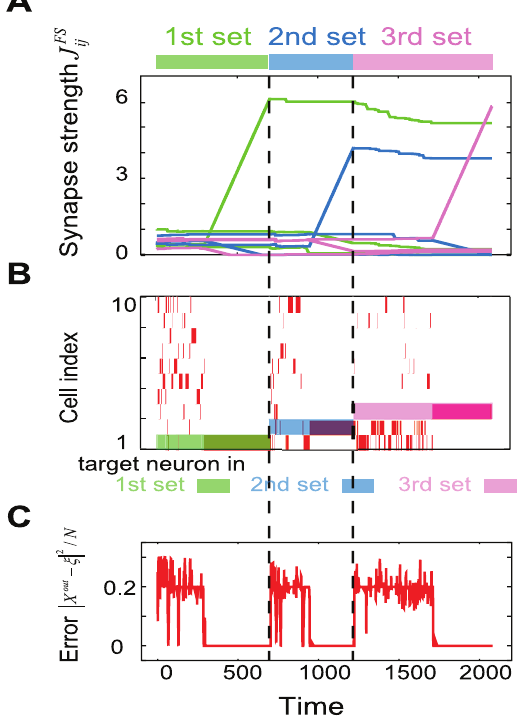
Figure 2. Dynamics during the learning of three input-output (I/O) mappings. I/O mappings are learned in the search phase by the anti-Hebbian rule (0 v t v 300, 700 v t v 950, and 1200 v t v 1700) and in the stabilization phase by the Hebbian rule (300 v t v 700, 950 v t v 1200, and 1700 v t v 2100). Color bars on the top of figures and above the time series in B) represent each set of input/target patterns. A) Dynamics of some FSs are shown. These lines represent FSs from neurons in hidden layer to the neurons to be activated in targets in output layer. These neurons are referred to as the target neurons. In particular, each color (green, blue and red) represents FSs to each target neuron (1st, 2nd and 3rd target) respectively. Three lines increasing rapidly are FSs from activated neurons in hidden layer to the target neurons. B) Raster plot of neurons in the output layer is shown. The ordinate shows the index of the neurons in the output layer. Red bar represents the high activity of each neuron ( x i w 0 : 9 ). Blue (green) bar behind the Raster plot indicates the output corresponding to the first (second) target. C) Time series of the amplitude of the error signal between the output and target patterns. Distance d between the output pattern X out and the target pattern j by the normalized Euclidean norm ( d ~ j X out { j j 2 = N ) as a function of time is